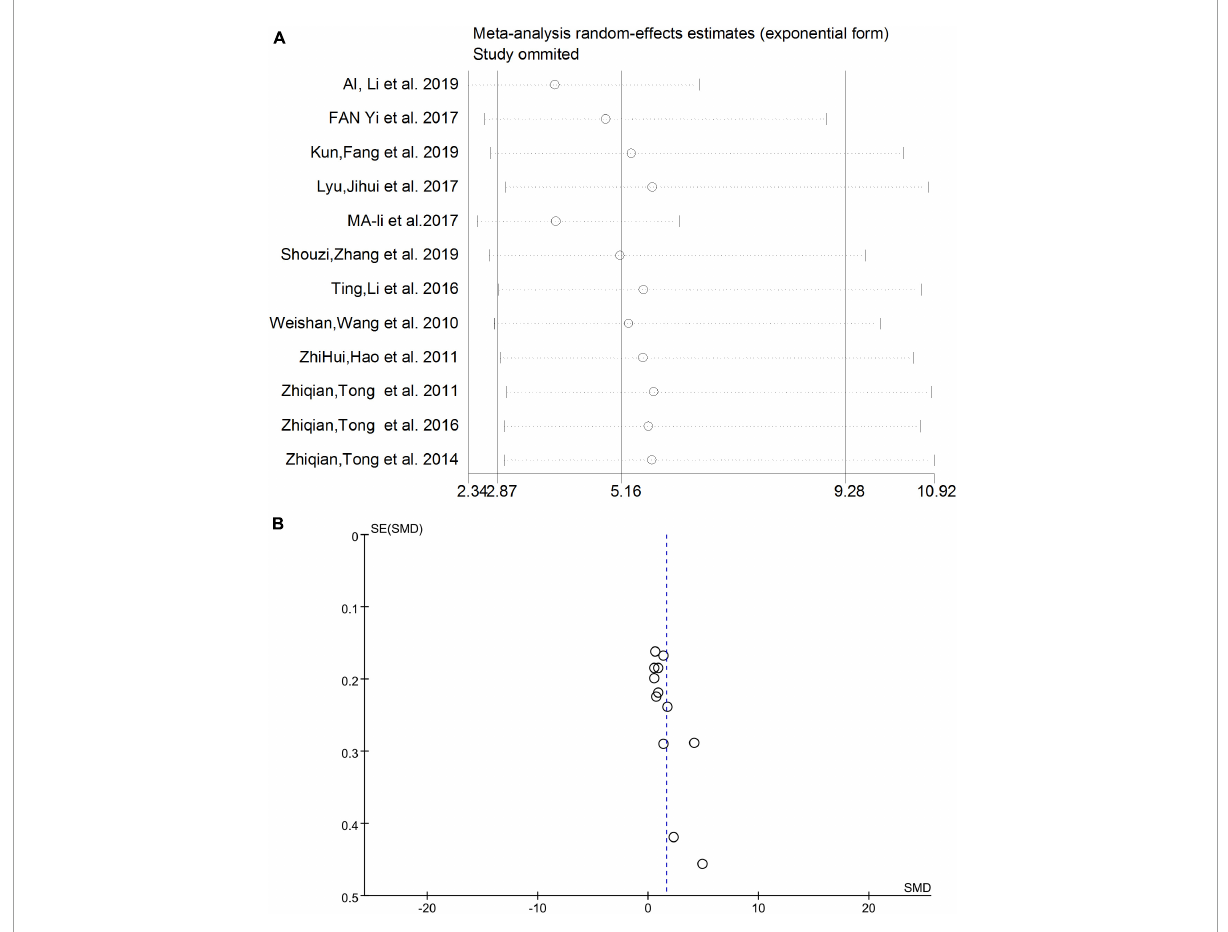
FIGURE4 (A) Sensitivity analysis excluding individual studies. (B) Funnel plot results of meta-analysis. SMD, standardized mean